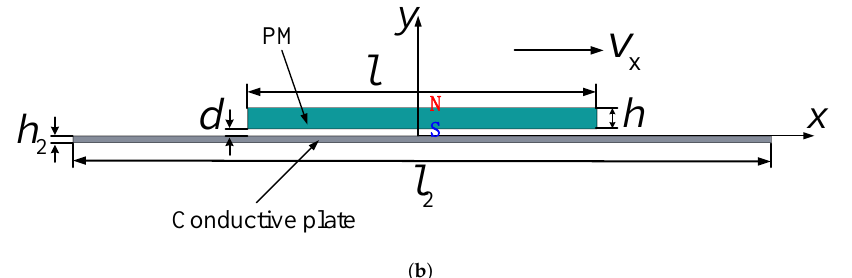
Figure 4. Structure of the suspension system. ( a ) Three-dimensional structure of the suspension system; ( b ) Two-dimensional structure of the suspension system.